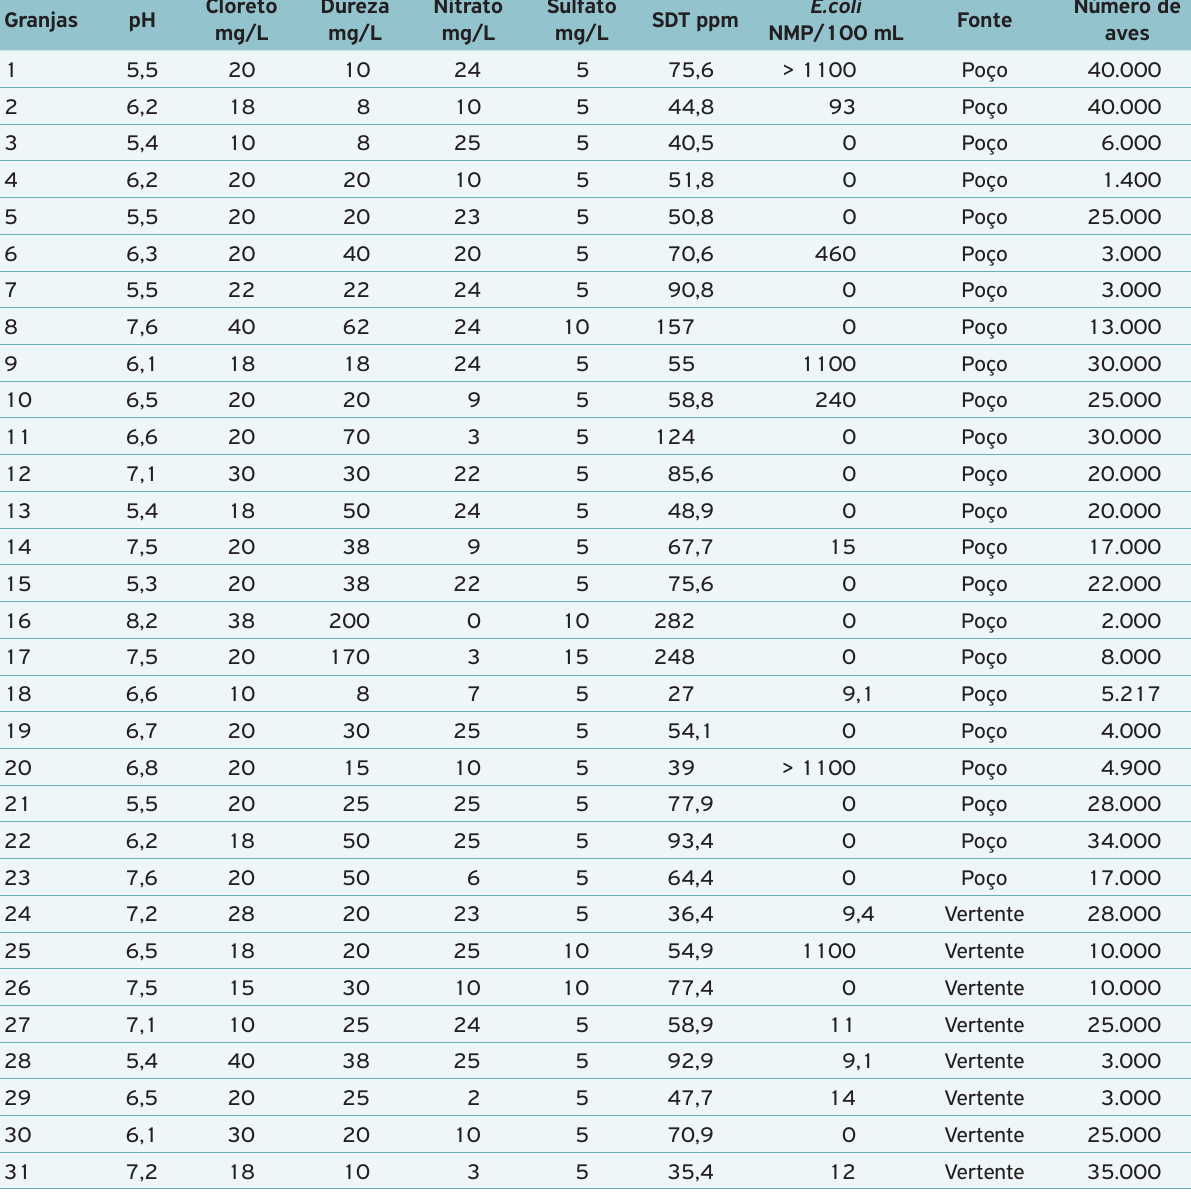
Tabela 4. Resultados das análises realizadas em cada